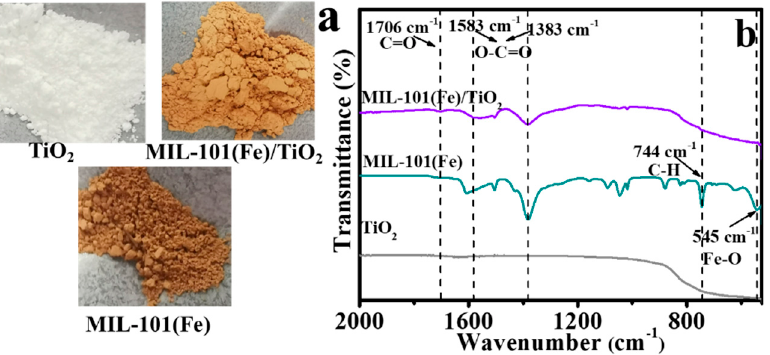
Figure 1. Different colors ( a ), and FTIR spectra ( b ) of MIL ‐ 101(Fe), TiO 2 , and MIL ‐ 101(Fe)/TiO 2